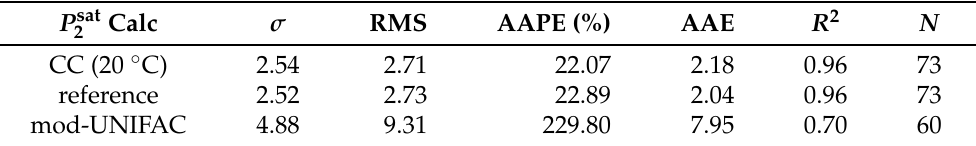
Table 5. Summary of the error in the predicted solvation free energy ( ∆ G solv , Equation (4)) for organic 2,1 solutes in water, where ∆ G solv is in units of kJ/mol. The error is quantified using the standard 2,1 deviation computed for the difference between the calculated and reference value ( σ ) and the root- mean-squared error (RMS), the average absolute percent error (AAPE), the average absolute error (AAE), and R 2 , where N is the number of organic solutes for which reference data were available. All of the data were at 25 ◦ C. Predictions were made for MOSCED with ln P sat computed using the 2 Clausius–Clapeyron equation with a reference temperature of 20 ◦ C plus the use of the reference vapor pressure for comparison. Predictions were additionally made using mod-UNIFAC with the reference vapor pressures.